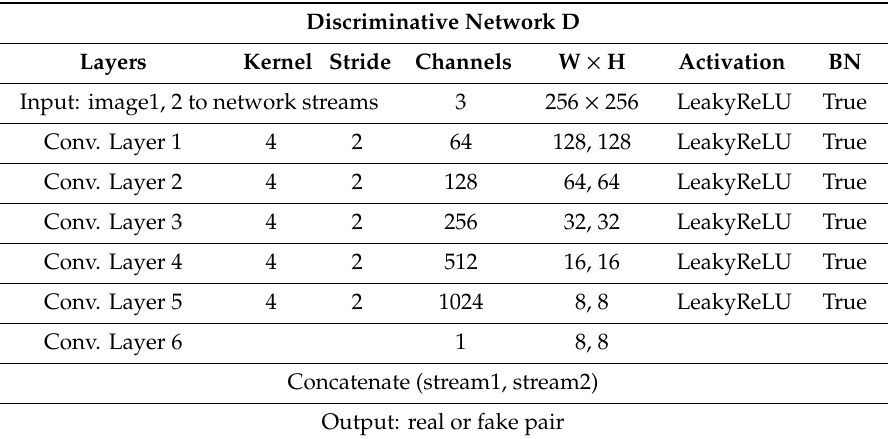
Table 2. The architecture of the Discriminative Network